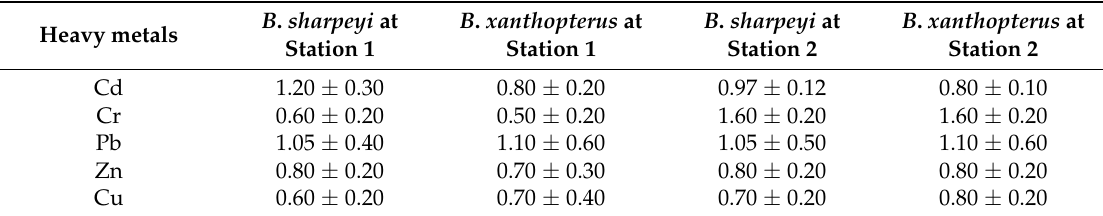
Table 3. Mean concentrations of heavy metals ( µ g/g) in the muscles of B . sharpeyi and B . xanthopterus at Station 1 and Station